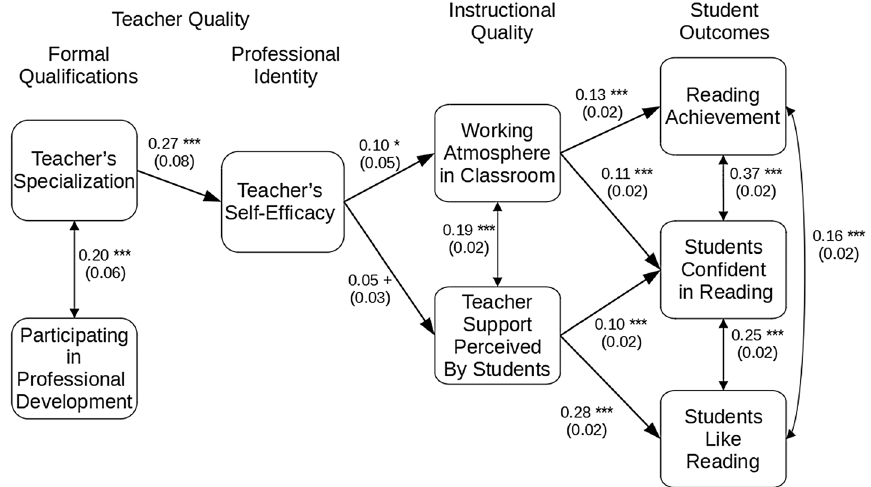
Fig. 6 Path analysis model for